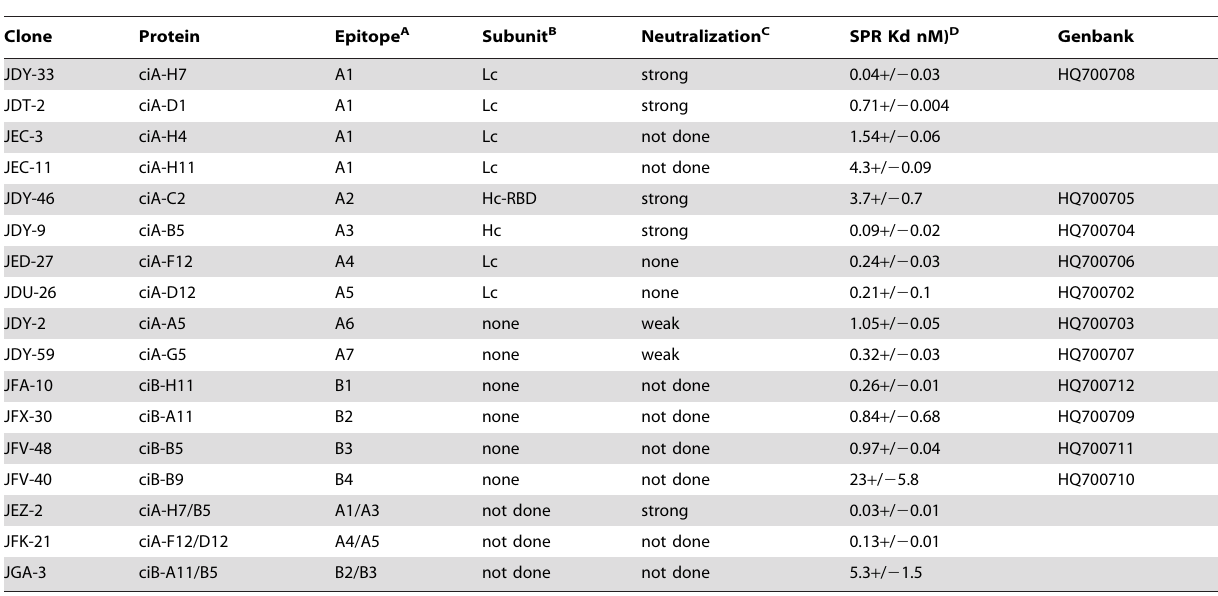
Table 1. Summary of VHH characterization